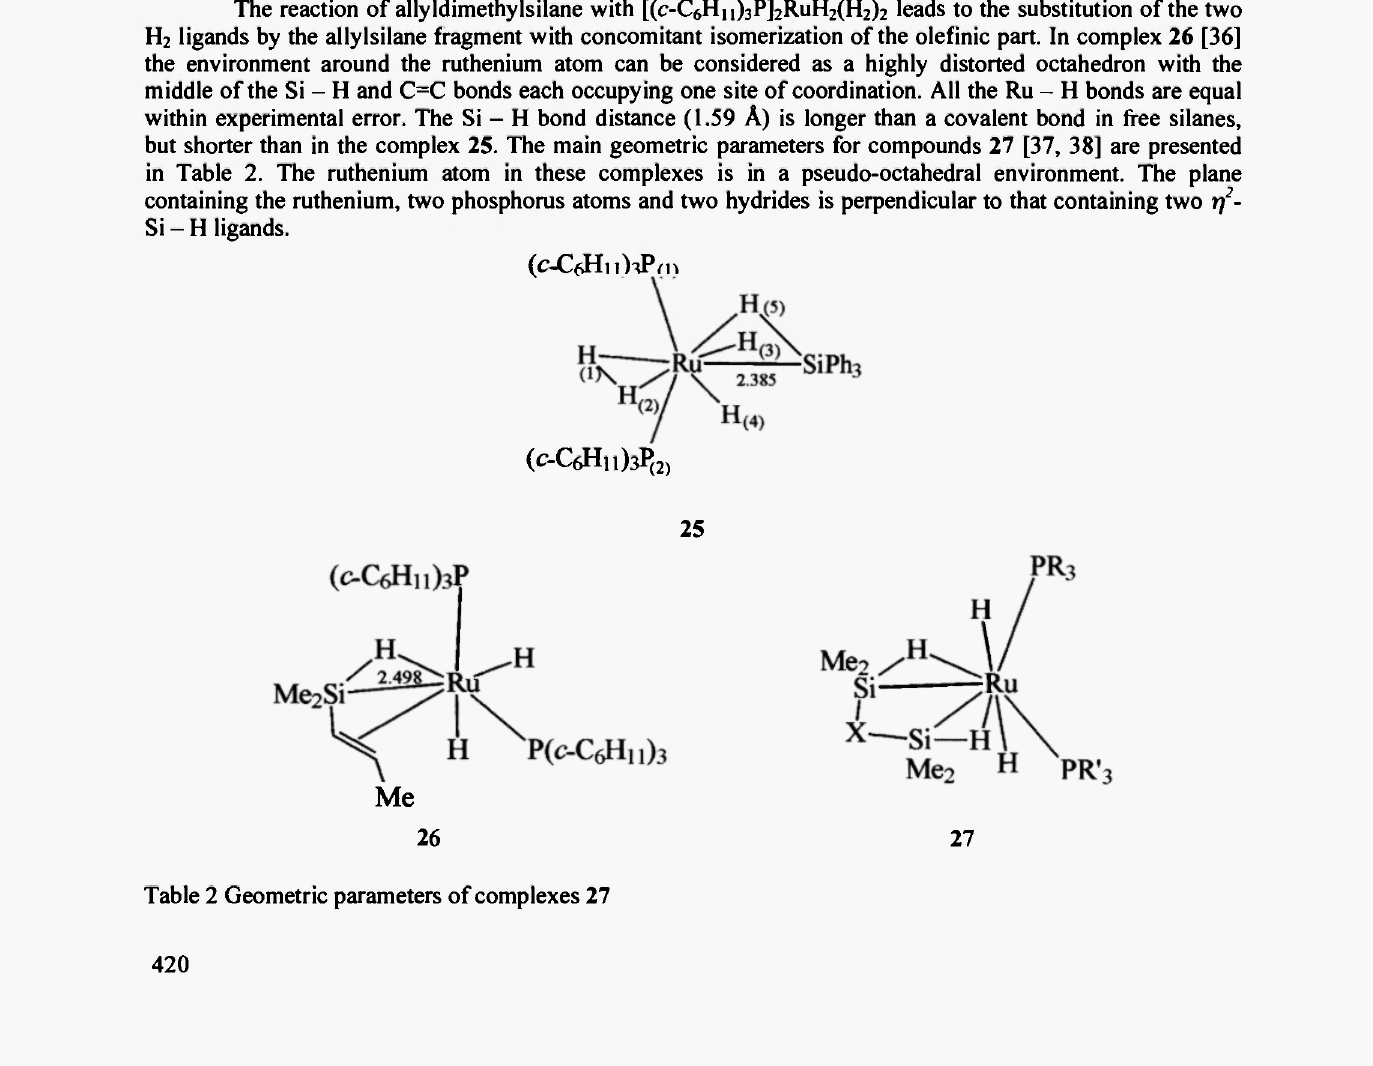
Table 2 Geometric parameters of complexes